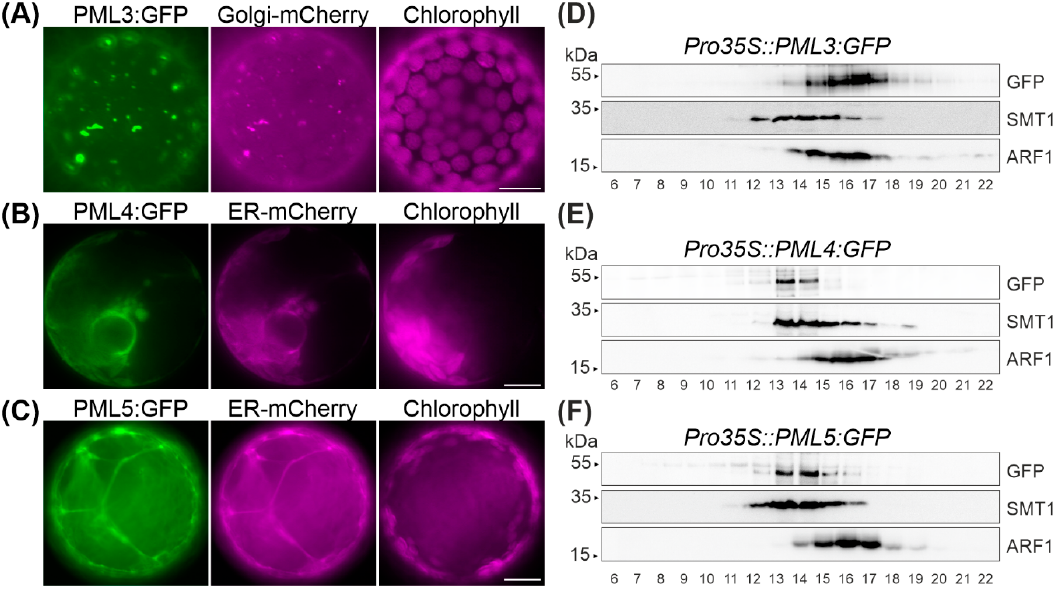
Figure 2. Fluorescence analysis of Nicotiana benthamiana protoplasts and immunoblot analysis of stable transformed Arabidopsis lines. ( A ) N. benthamiana leaves were infiltrated with pPro35S::PML3:GFP and pG-rk (=Golgi-mCherry); a second focus layer and corresponding overlay and bright field photographs are shown in Figure S1. ( B ) N. benthamiana leaves were infiltrated with pPro35S::PML4:GFP and pER-rk (=ER-mCherry); a second protoplast with overlay and bright field photographs is shown in Figure S1. ( C ) N. benthamiana leaves were infiltrated with pPro35S::PML5:GFP and pER-rk (=ER-mCherry). ( A – C ) GFP fluorescence of the indicated fusion protein is depicted in green, mCherry fluorescence and chlorophyll autofluorescence are depicted in magenta. Scale bar = 10 µm. ( D – F ) Separation of isolated microsomes of the indicated stable transformed Arabidopsis line by sucrose density centrifugation (20% to 50%). Top-down aliquots of fractions as indicated, were separated by SDS-PAGE and analyzed by immunodetection using anti-GFP, anti-sterol methyltransferase 1 (SMT1) and anti-ADP-ribosylation factor 1 (ARF1) antibodies. The individual lines used for this experiment were Pro35S::PML3:GFP #1, Pro35S::PML4:GFP #1 and Pro35S::PML5:GFP #1, as indicated in Figure S2.